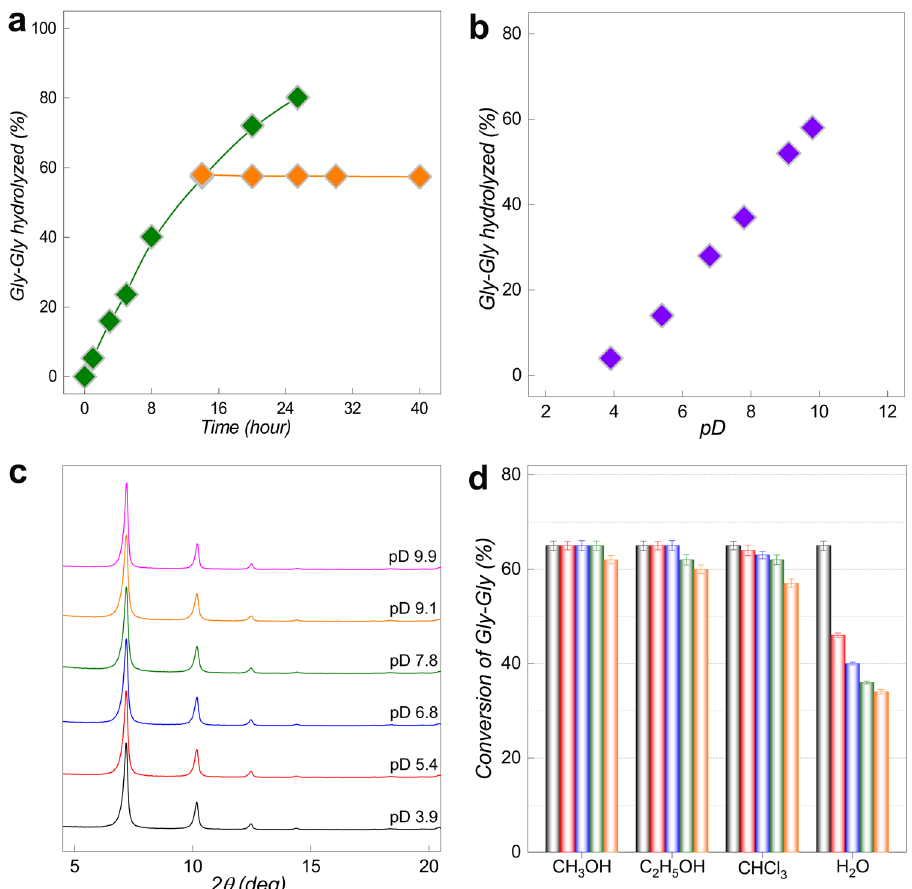
Fig. 3 Catalytic performance of MIP-201 for hydrolysis of Gly – Gly. a Hydrolysis of 2.0 µ mol of Gly – Gly in the presence of 2.0 µ mol of MIP-201 before (green square) and after (orange square) the removal of MIP-201 (pD 7.4 and 60 °C). b Conversion of Gly-Gly after eight-hour hydrolysis of Gly – Gly (2.0 µ mol) catalysed by MIP-201 (2.0 µ mol) at 60 °C and different pD values. c PXRD patterns of MIP-201 after eight-hour catalysis at 60 °C in reaction solution of different pD values ( λ Cu ≈ 1.5406 Å). d Conversion of Gly – Gly after sixteen hours at 60 °C in the presence of MIP-201 for fi ve reaction cycles. Different organic solvents were used to wash and exchange with water before a four-hour activation at 120